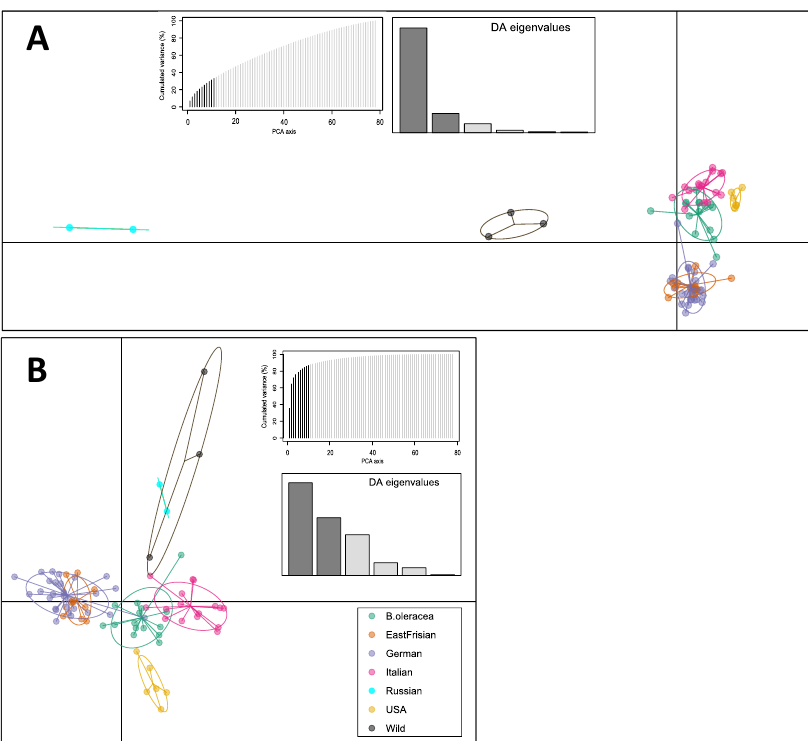
Figure 3. Discriminant analysis of principal components (DAPC). Scatterplot showing the first two principal components for the samples obtained from ( A ) SNP data of the filtered dataset, and ( B ) using the SPLoSH information. Dots represent individual samples; clusters are marked with ellipses. Graphs of the PCA and DA eigenvalues retained are shown. Plots labelled with sample names are provided as Supplementary Figure S4.